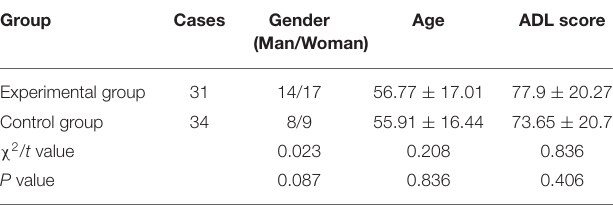
TABLE 3 | Comparison of Panas scores between the two groups.